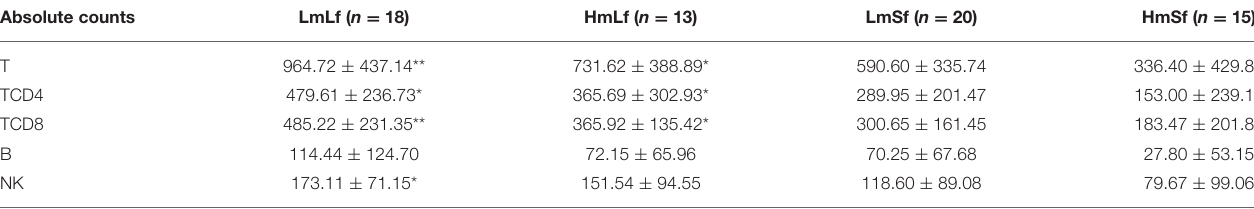
MELD, model for end-stage liver disease; T, CD3 + T cells; TCD4, CD3 + CD4 + T cells; TCD8, CD3 + CD8 + T cells; B, CD19 + B cells; NK, CD56 + CD16 + natural killer cells; Lm, low MELD score; Hm, high MELD score; Sf, short-term follow-up; Lf, long-term follow-up.